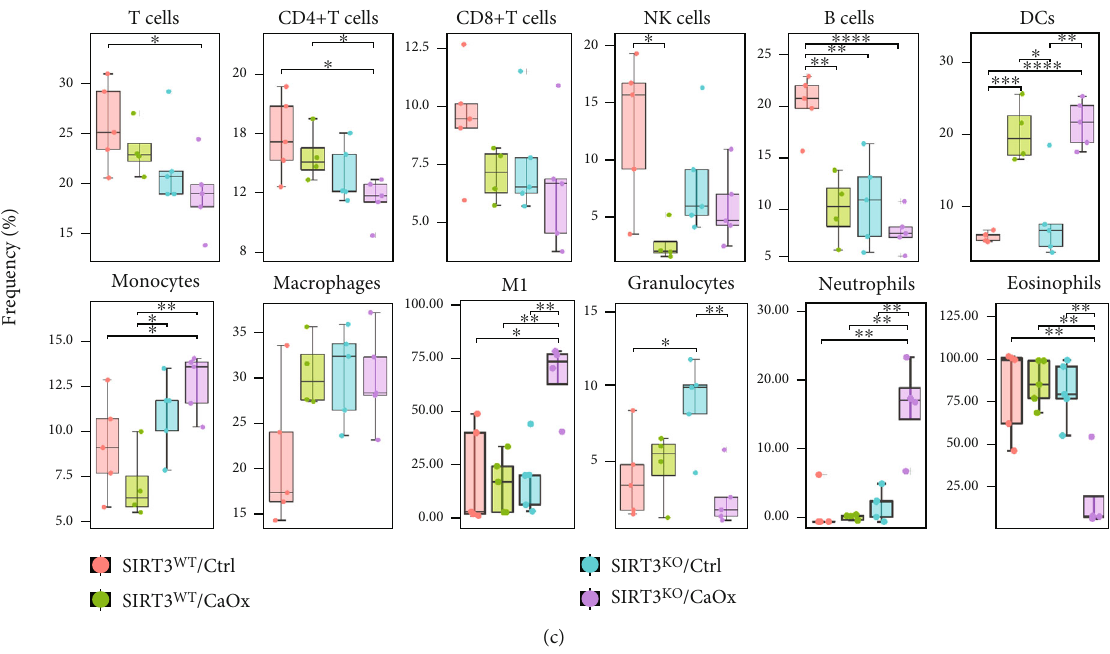
Figure 5: Immune cell population changes after SIRT3 knockout and CaOx inducement. (a) t-SNE maps displaying 9935 cells analyzed with 42-antibody panel and colored by di ff erent models. (b) Frequencies of 11 intrarenal immune cell populations for each nephrolithiasis sample. Cell types are indicated by color. (c) Boxplots showing the frequencies of indicated immune cell clusters among four di ff erent models with SIRT3 wild-type or knockout and CaOx inducement or not. ∗ P < 0 : 05 , ∗∗ P < 0 : 01 , ∗∗∗ P < 0 : 001